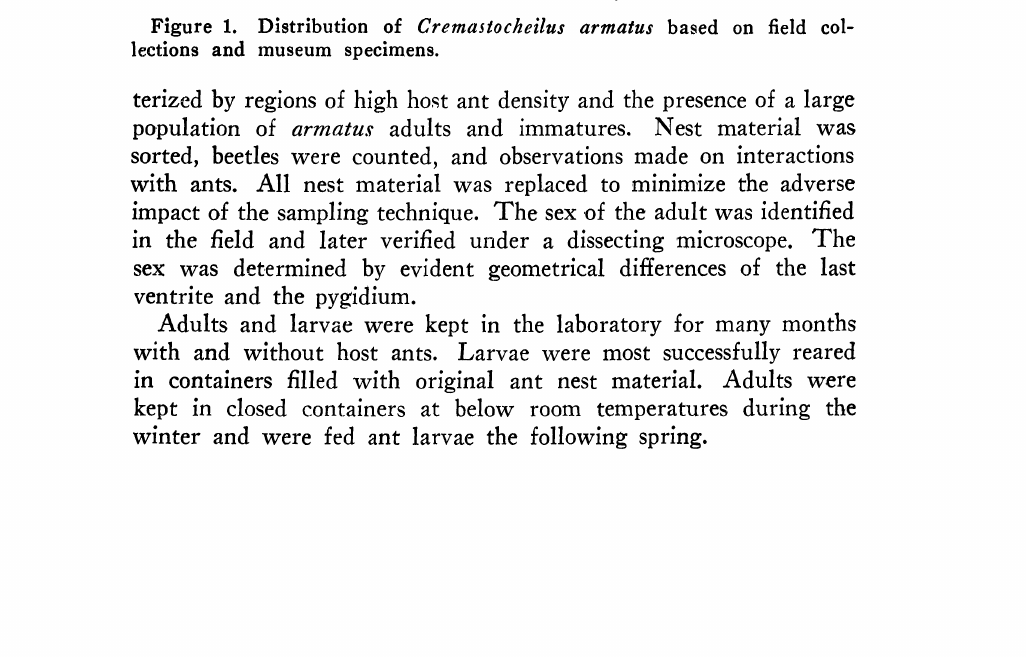
Figure 1. Distribution of Gremastocheilus armatus based on field col- lections and museum